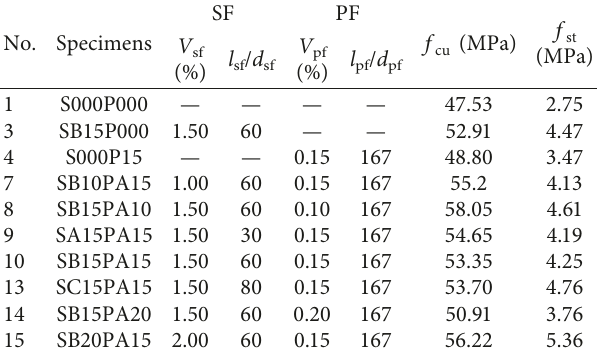
Table 3: Details of